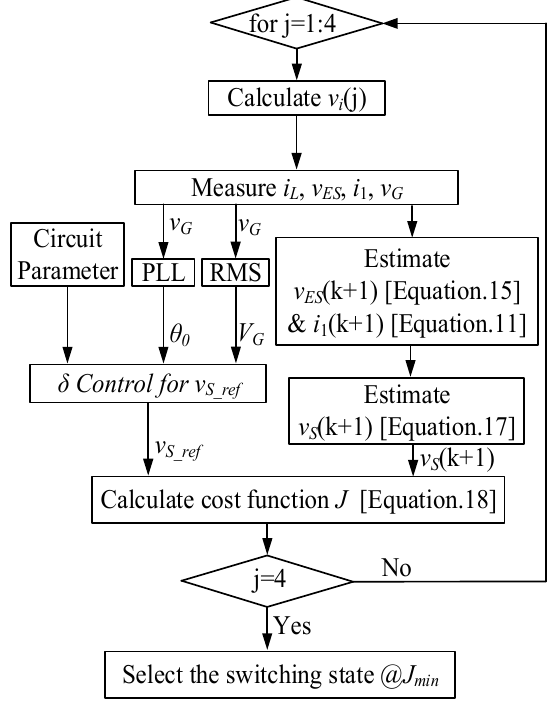
Figure 4. Program flowchart of MPC and δ